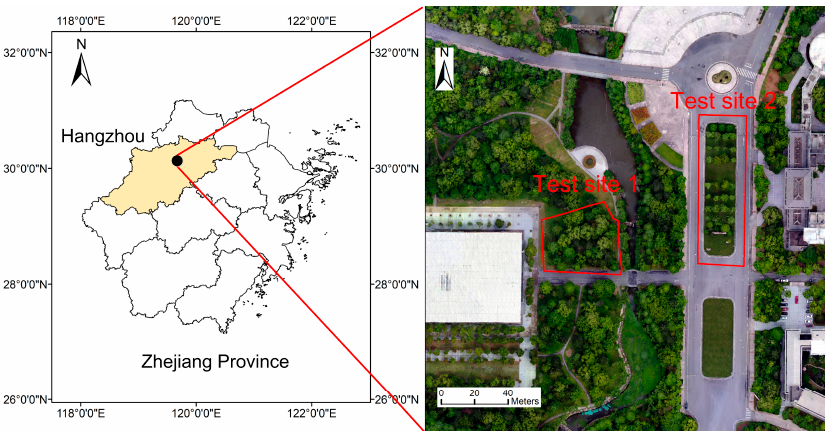
Figure 1. Location of the study area.